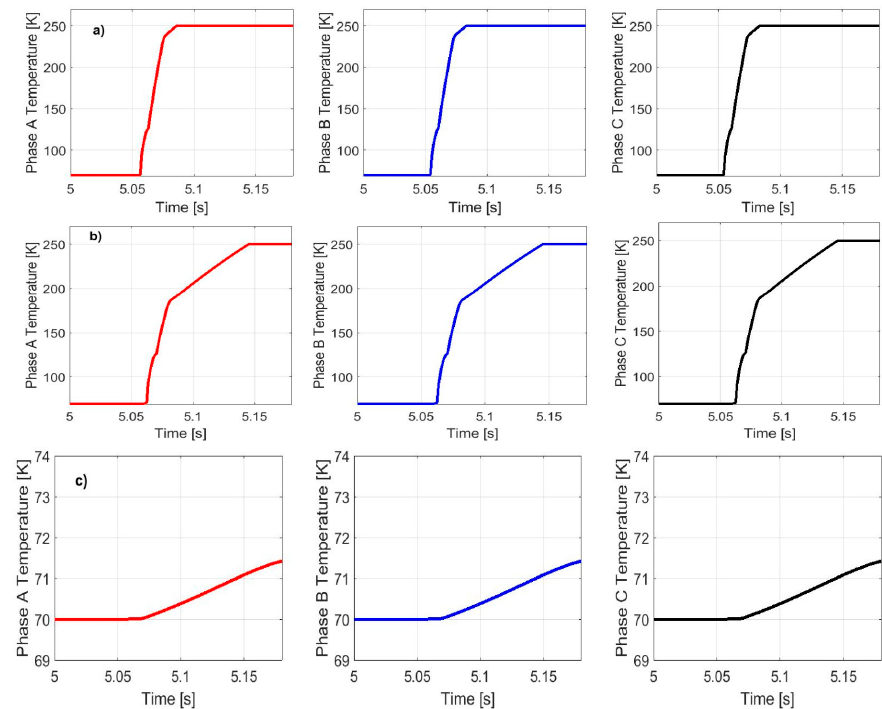
Figure 20. Temperature for phases A, B, and C for 3-Phase-to-ground fault at 50% of cable’s length,